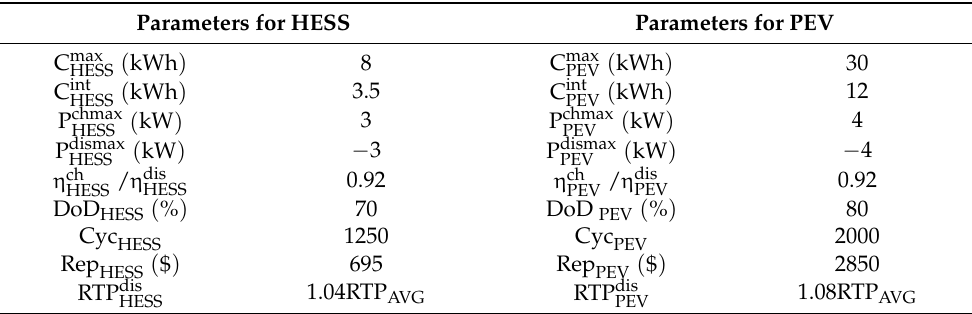
Table 3. Parameters of HESS and PEV.